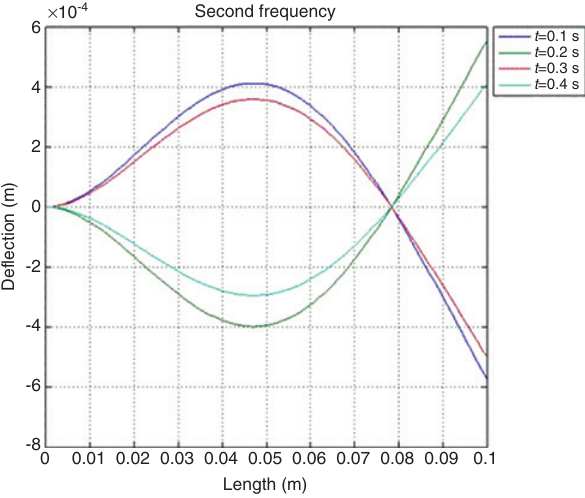
Figure 4: Vibrations of second characteristic mode of the cantilever beam.